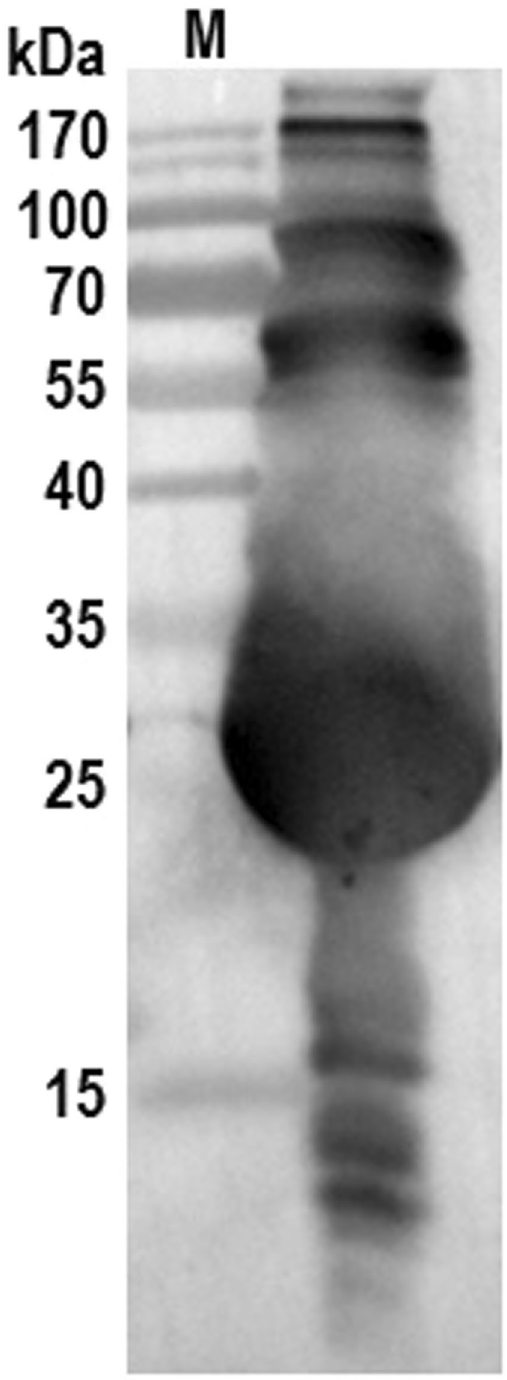
Figure 5. Western blot analysis of the protein polyhedrin in the polyhedra matrix. Total proteins of the polyhedra matrix fraction were subjected to SDS-PAGE and then Western blot using a mouse monoclonal anti- polyhedrin antibody 166 . Proteins were visualized using a goat anti-mouse secondary antibody conjugated to HRP and a chemiluminescence detection system. Lane M, the protein